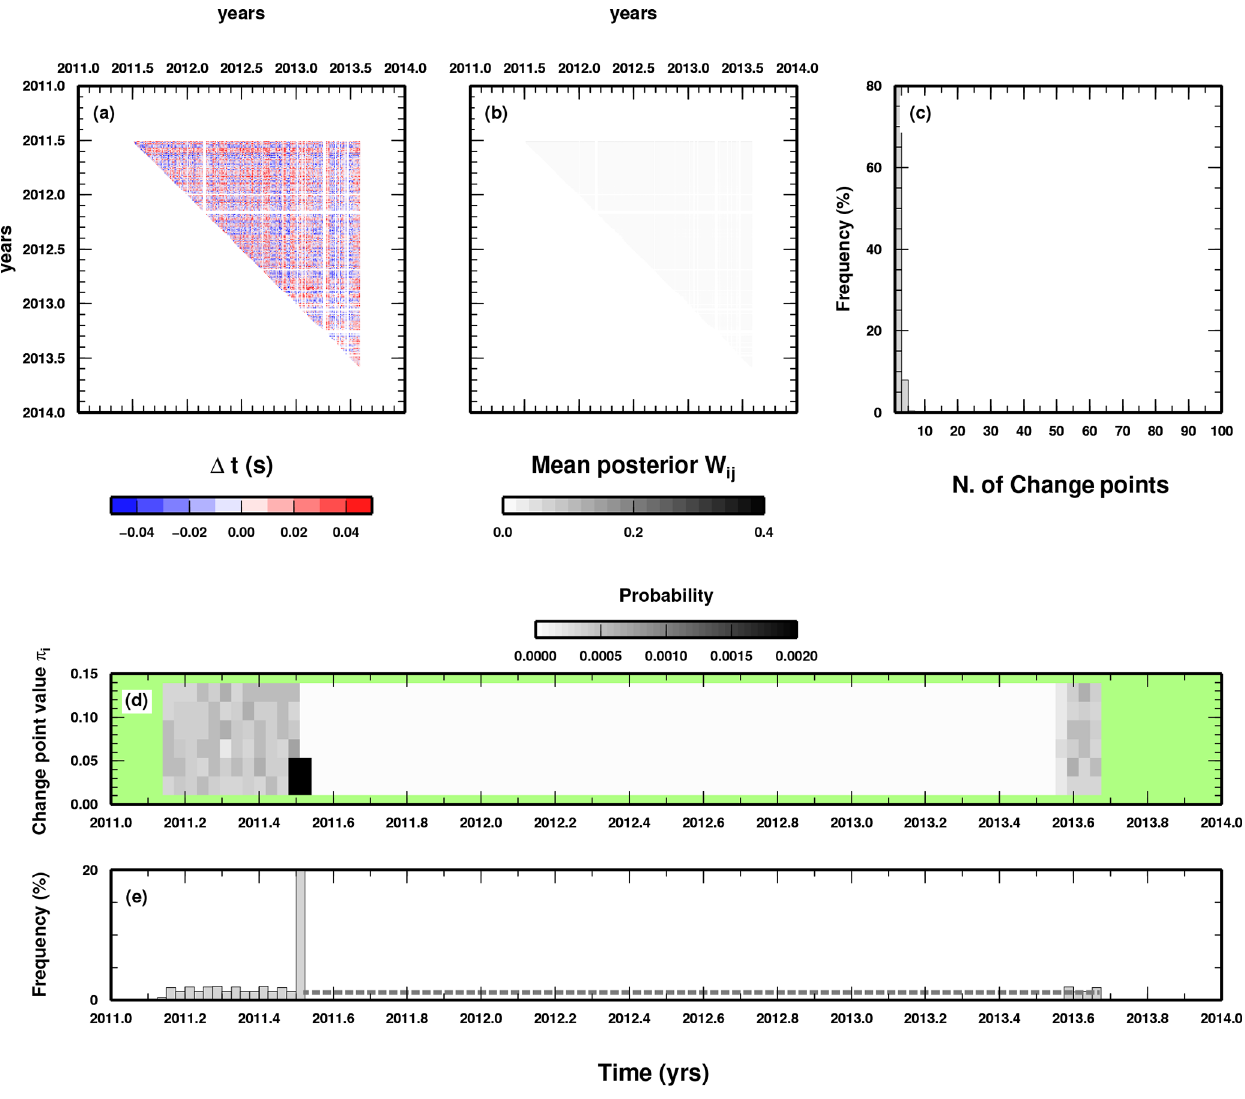
Figure A1. Results of the synthetic test wherein “observed” data have been created without changepoints. Figure details are the same as in Fig. 5. In panel (a) we show the synthetic data used as input to the